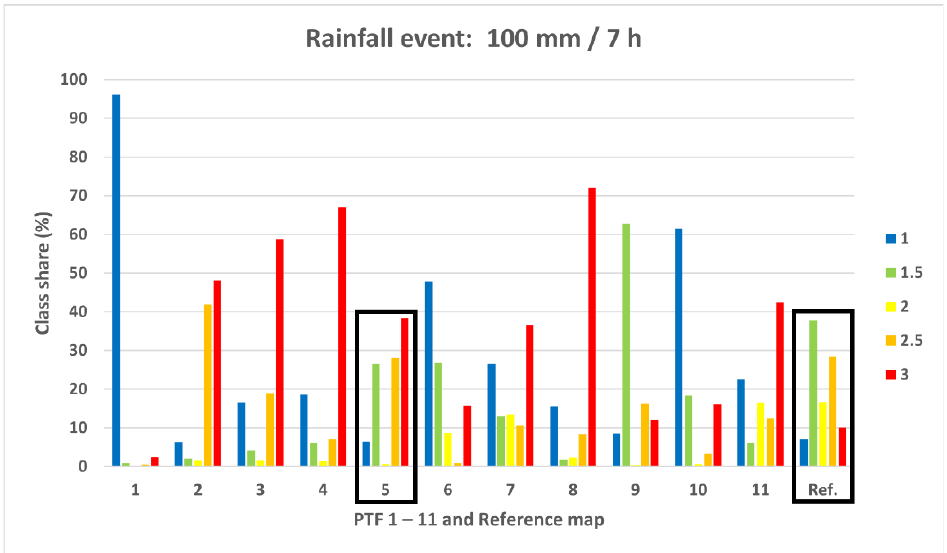
Figure 7. Percentage share of DRP classes for the entire catchment in the reclassified reference map and corresponding simulations for all PTFs and a precipitation intensity of 100 mm/7 h.